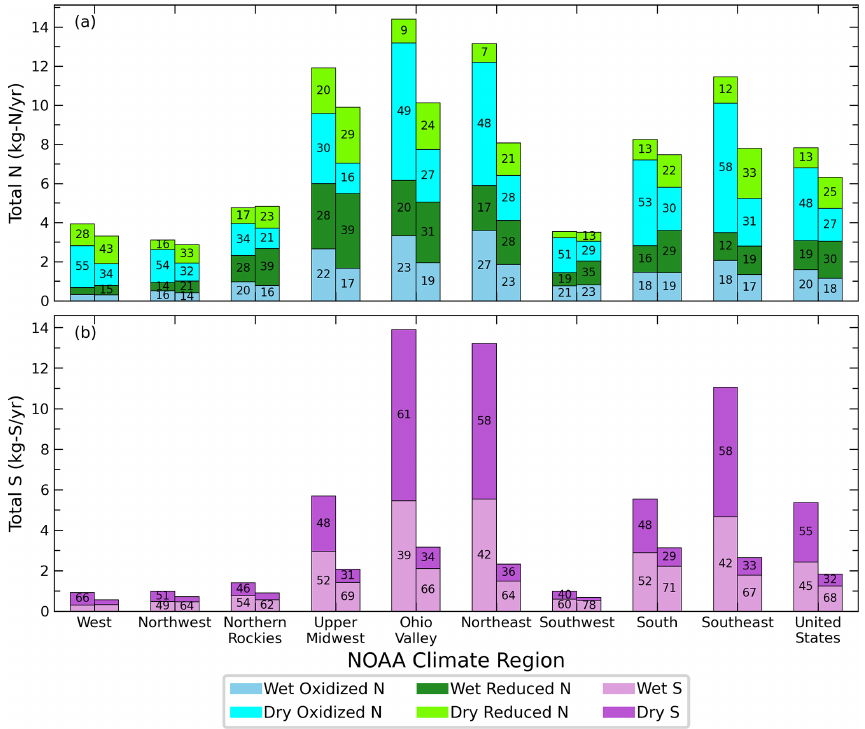
Figure 9. Average total (wet + dry) N (a) and S (b) deposition in 2002 (left bars) and 2017 (right bars) throughout the nine climate regions and CONUS. Colors denote the wet and dry component of each species. The numbers in each bar denote the percentage contribution to the annual